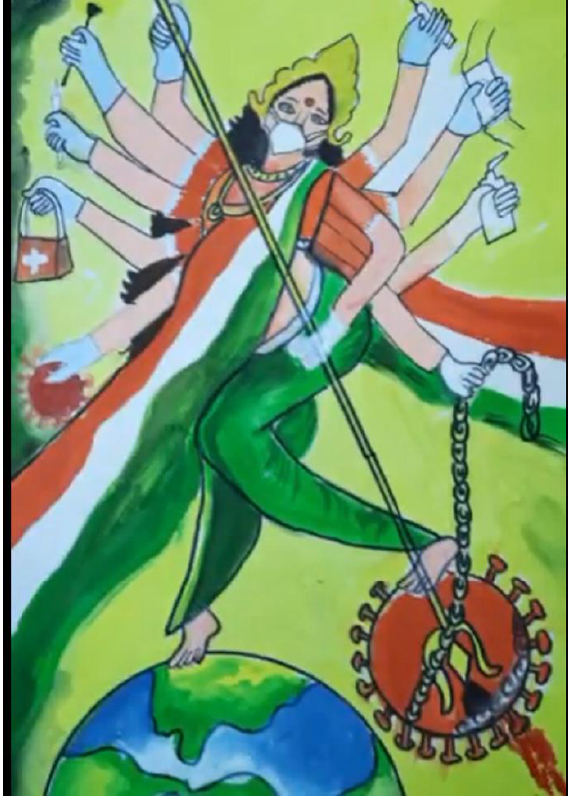
Figure 1. Coronavirus Mardhinī, painted by Ritu Arts inspired by Sandhya Kumari’s Mā Bhāratī Source: https://www.youtube.com/watch?v=eloXElXi4EA, accessed on 20 December